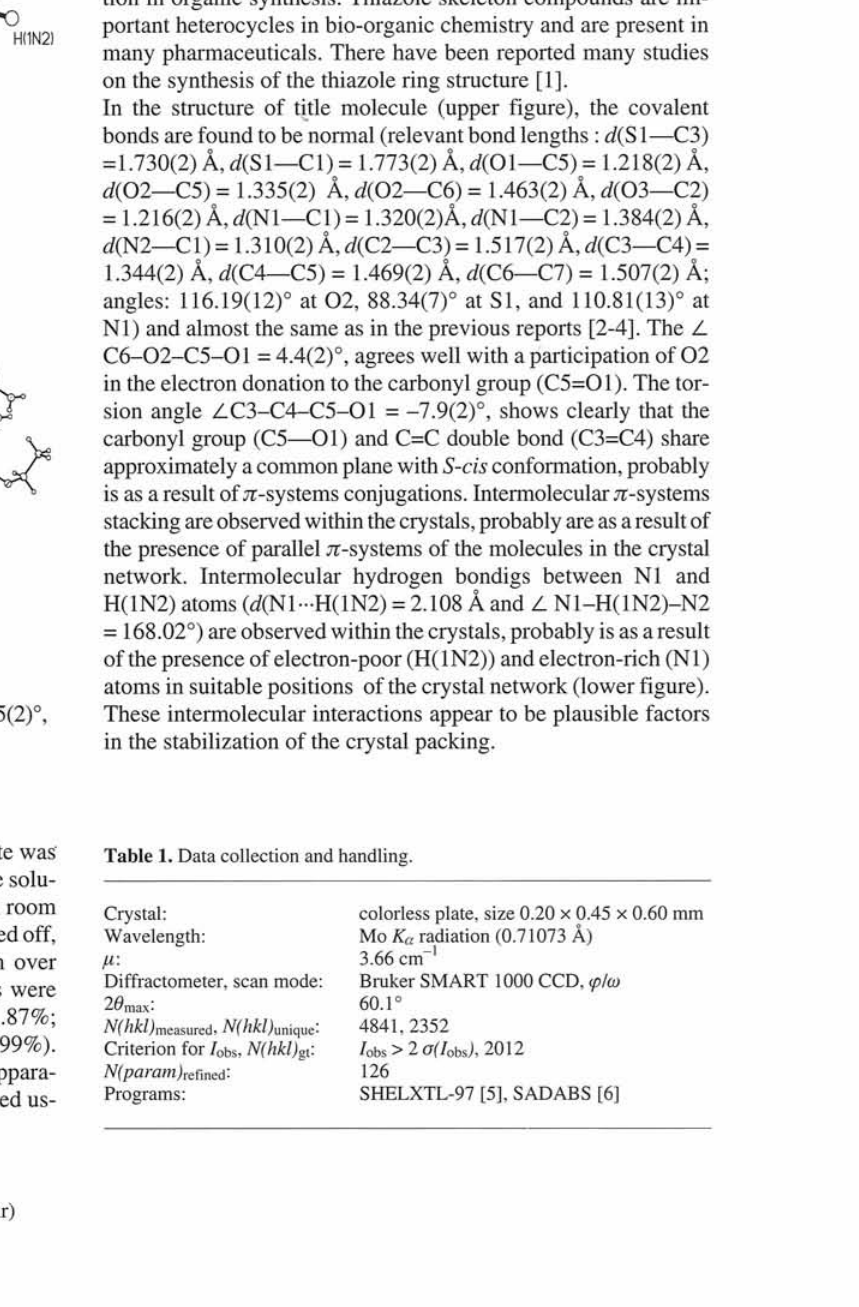
Table 1. Data collection and